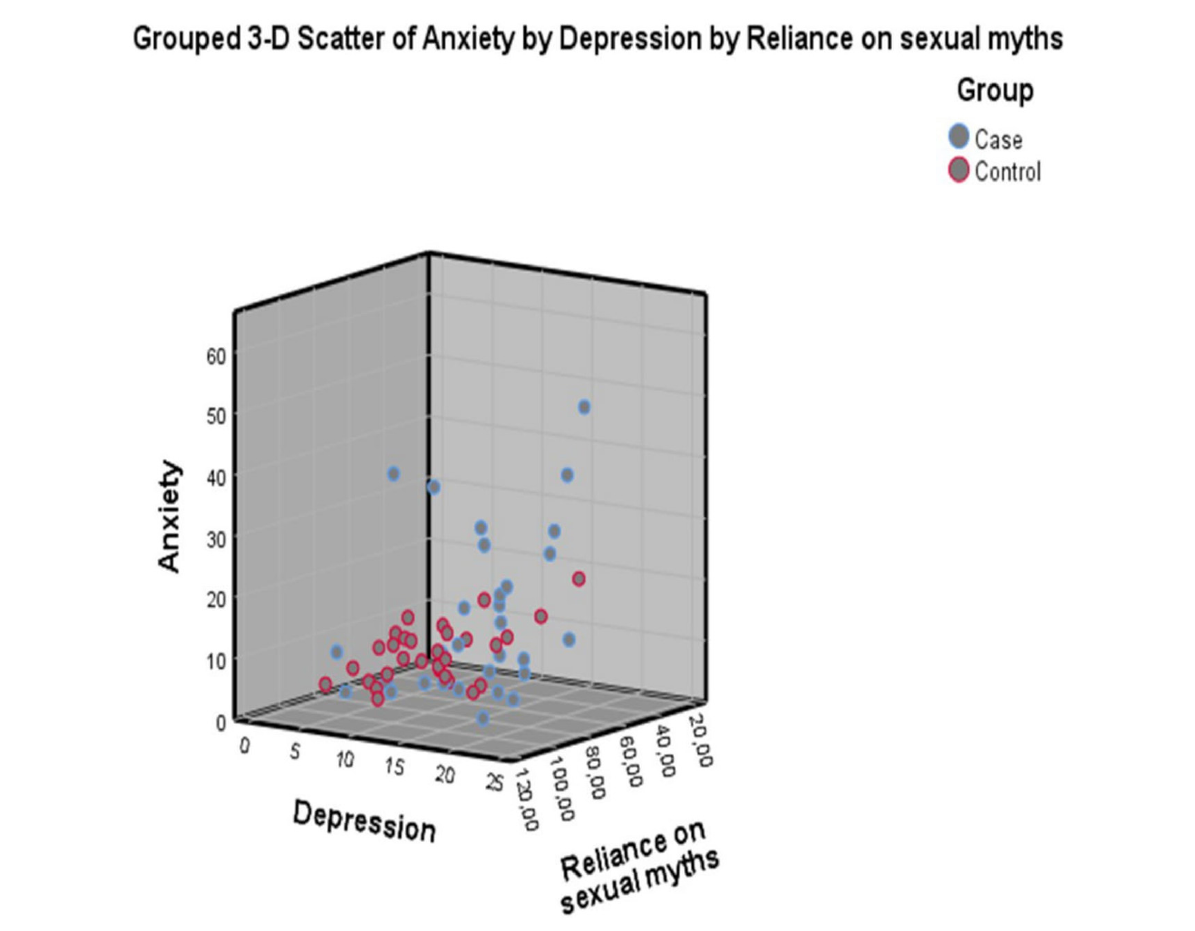
FIGURE1 Scatter plot of believing sexual myths, depression, and anxiety in case and control groups ( N =